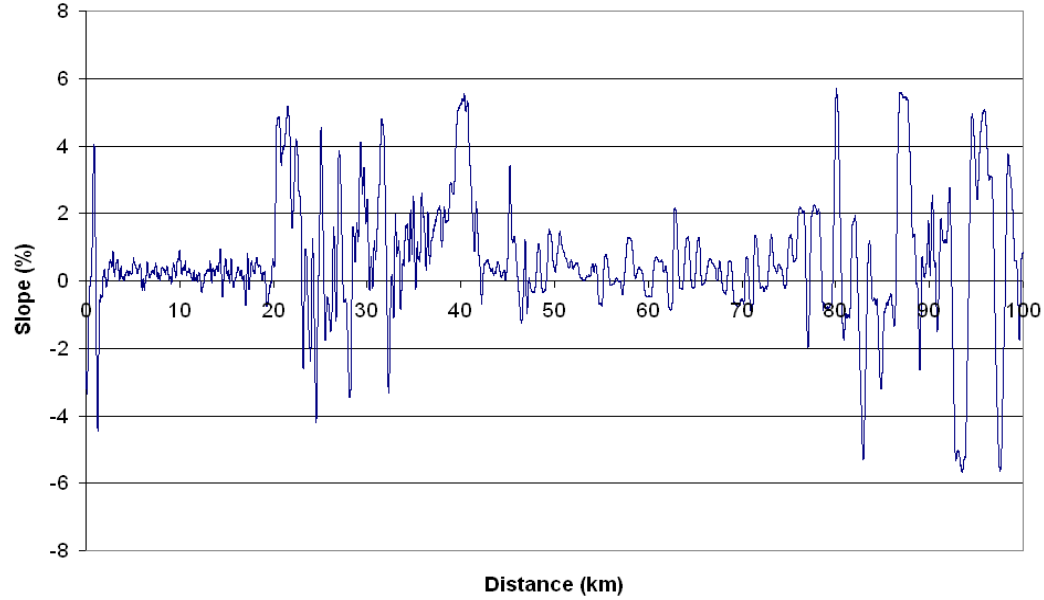
Figure 4. Road slopes profile.